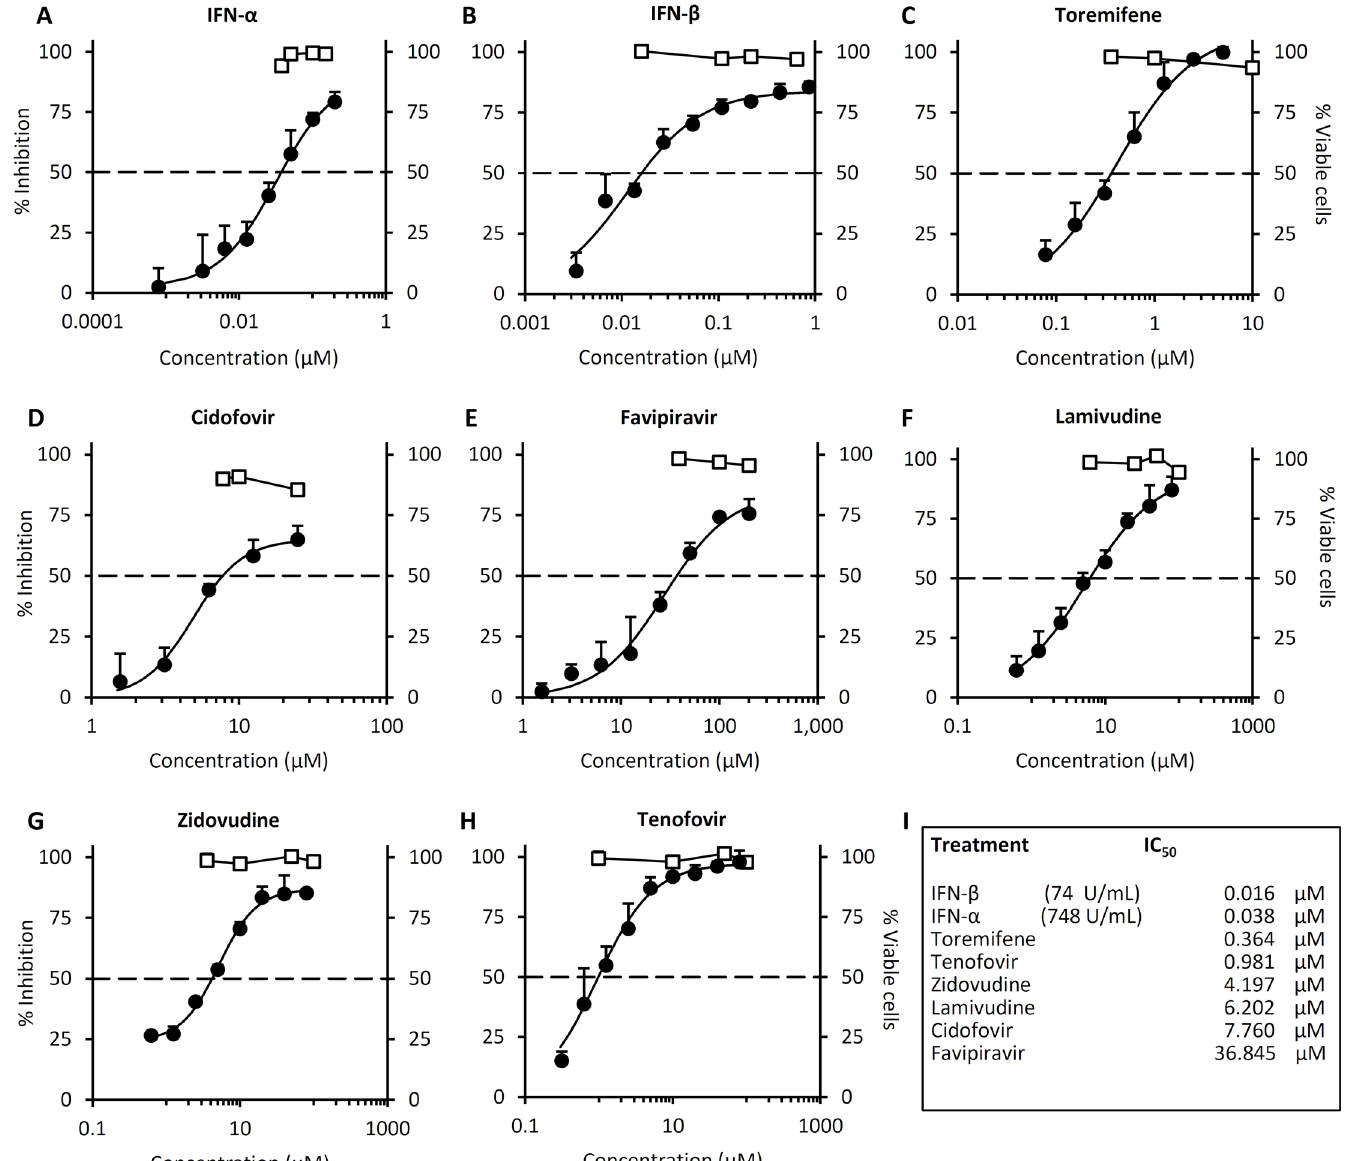
Fig 2. IFNs, toremifene and nucleoside analogs administered 24hrs post-exposure inhibit Ebola-mini-genome replication. 293 T cells were either left untreated (-), transfected with the mini-genome and the nucleocapsid plasmids NP, VP30, VP35 and T7 (-L), or transfected with the mini-genome and all expression plasmids to permit Ebola mini-genome entry and replication (+), as described in Materials and Methods. 24 hours post-trVLP infection, cells were either left untreated, or treated with the indicated drugs (A-I) Dose-response plots for each of the indicated drugs. Luciferase activity (black circles) or cell viability (white squares) was measured 4 days post-infection (3 days after drug treatment). Values are the means of 4 biological replicates and are representative of 2 independent experiments. Error bars are the standard error of the mean. See also S2 and S3